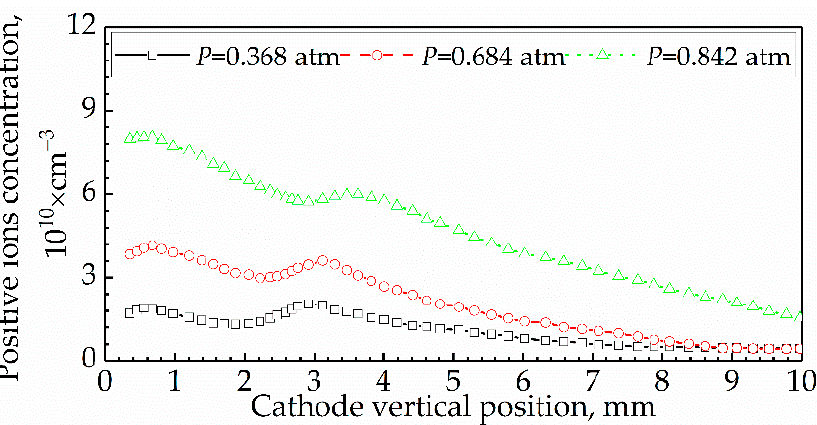
Figure 15. Profiles of the total concentration of positive ions in propane/air flames.